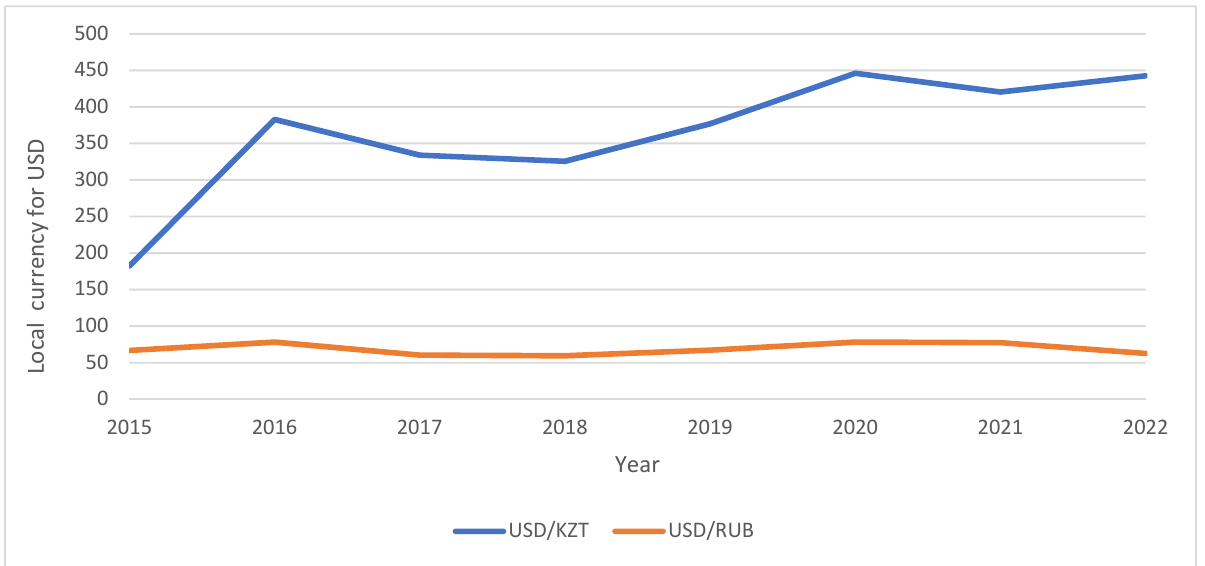
Figure 3. Dynamics of mutual trade across the EAEU countries, USD million. Source: Our own calculations based on World Bank (2022).